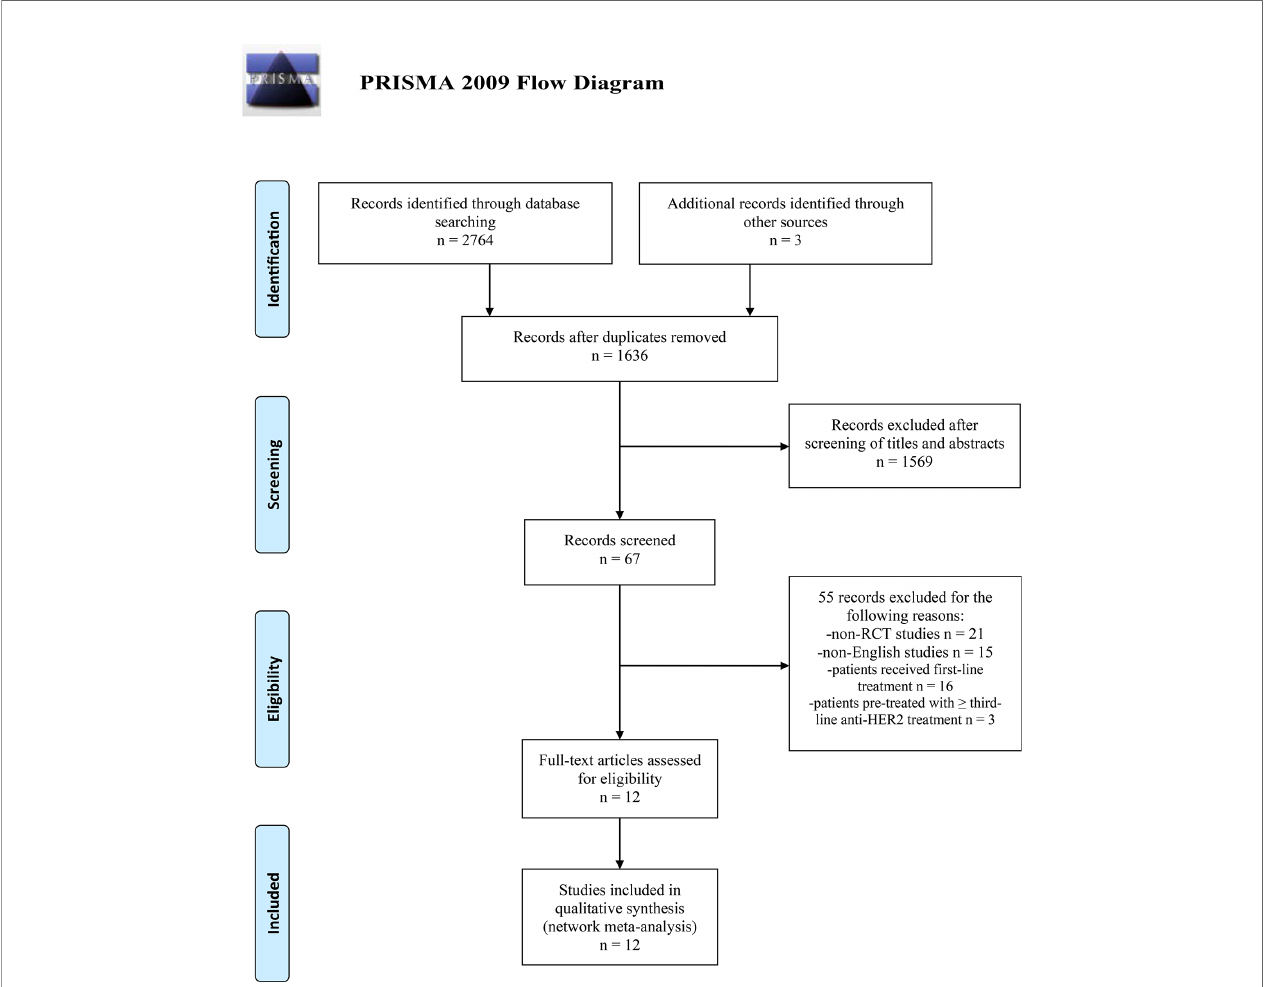
FIGURE 1 | PRISMA 2009 Flow Diagram of study selection process. PRISMA, Preferred Reporting Items for Systematic Reviews and Meta-Analysis; RCT, randomized controlled trial; HER2, human epidermal growth factor receptor